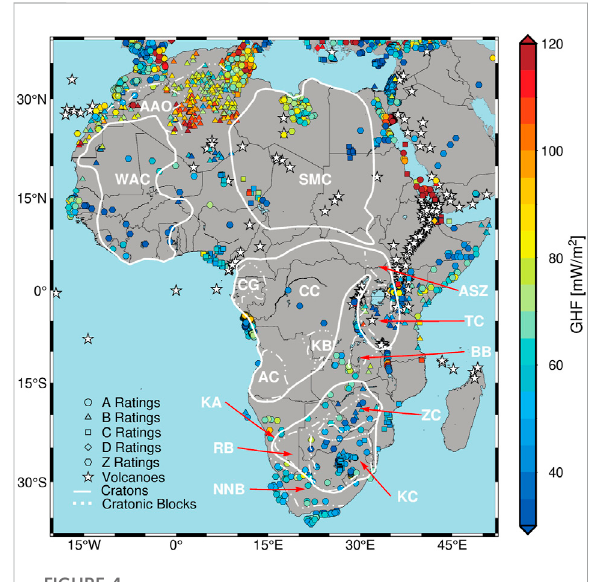
FIGURE 4 Simpli fi ed tectonic map of Africa with Cratons, Cratonic blocks, and other relevant tectonic units. Cratons are plotted in whitepolygons,KA=KalahariCraton;CC=CongoCraton;WAC= West African Craton; SMC = Saharan Metacraton. Cratonic blocks: BB = Bangweulu Block; ZC = Zimbabwe Craton; TC = Tanzanian Craton; KC = Kaapvaal Craton; AC = Angola Craton; KB = Kasai Block; GC = Gabon – Cameroon Block. RB = Rehoboth Block; NNB = Namaqua-Natal Belt; ASZ = Aswa Shear Zone. Symbols of circle, triangle, square, diamond and hexagon represent the Reference GHF with A , B , C , D , and Z ratings respectively, derived from the global compilation of GHF database (Lucazeau, 2019). White asterisks = distribution of